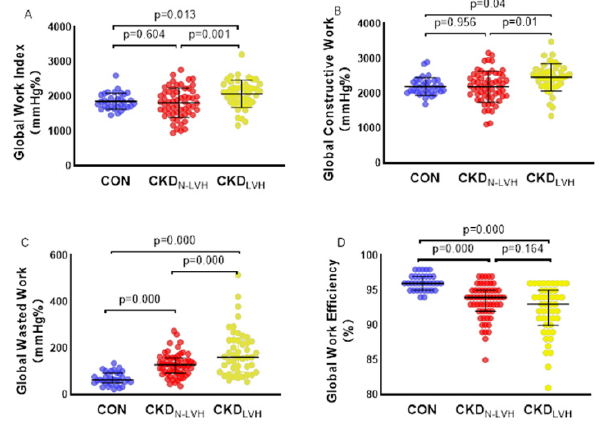
Figure 1. Effect of left ventricular hypertrophy on myocardial work. ( A ) Global work index, ( B ) global constructive work, ( C ) global waste work, ( D ) global work efficiency. CON: control group; CKD N-LVH : the chronic kidney disease with normal left ventricle group; CKD LVH : the chronic kidney disease with left ventricular hypertrophy group.